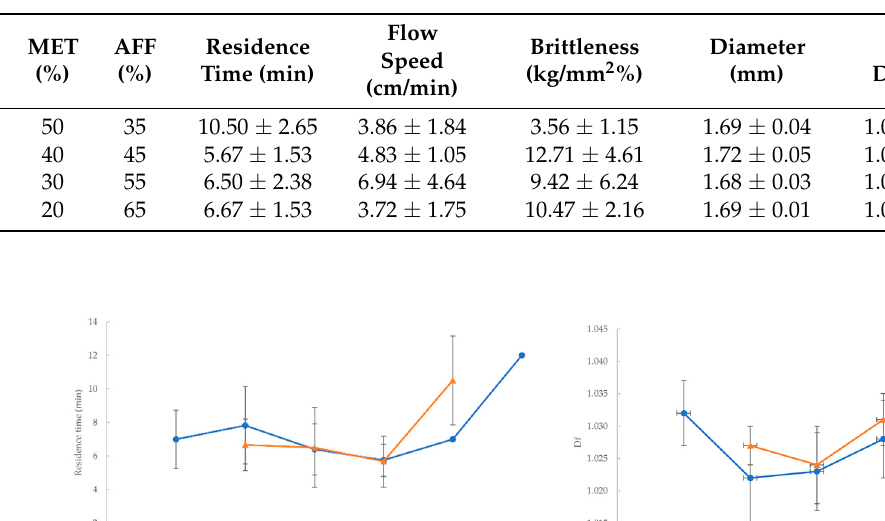
Table 4. Extrusion process parameters and filament parameters of blends containing 7.5% of both MS and PEG 6000 with 20% to 50% MET.